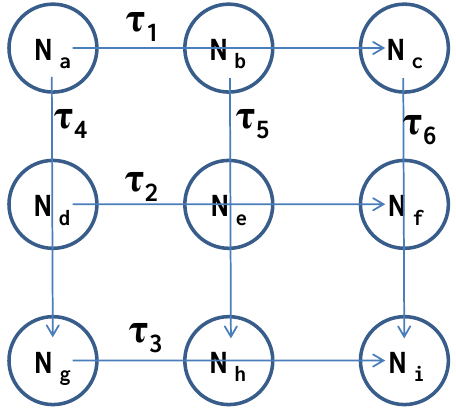
Figure 2. A typical real-time distributed system.